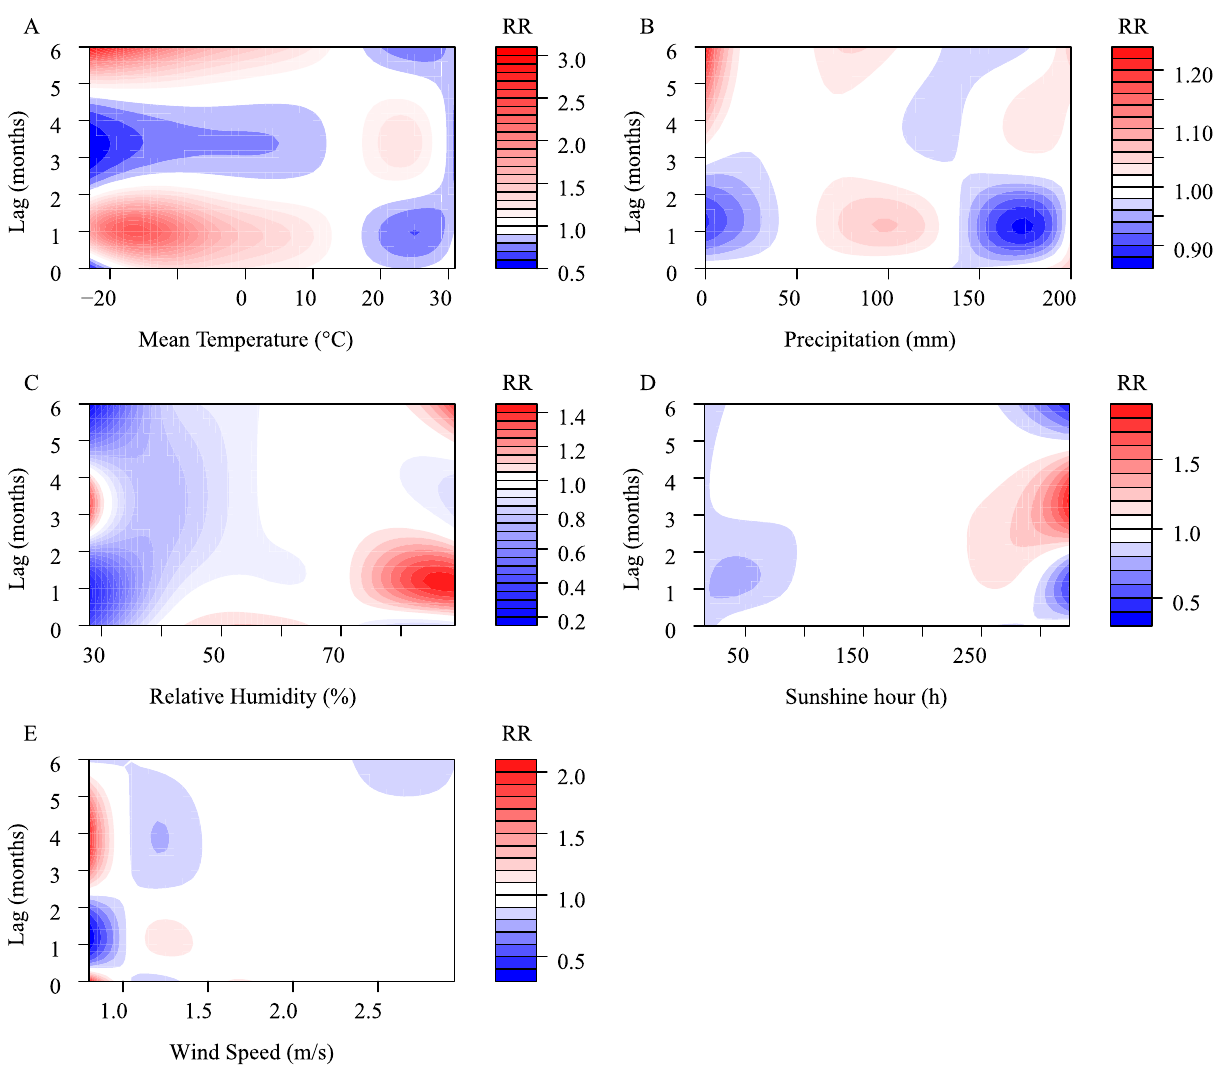
Figure 5. Contour plot of the exposure–response relationship between the incidence of HFRS and five meteorological conditions in the multivariate model. The Y-axis represents the lag period from 0 to 6 months. The x-axis represents the range of observations for each variable. RR stands for relative risk, red stands for RR > 1, white stands for RR = 1, and blue stands for RR <